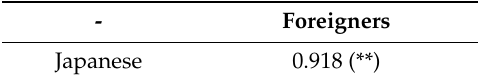
Table 4. Correlation coe ffi cient between Japanese and foreign nationals associated with oppressive feeling. (**: p < 0.01).